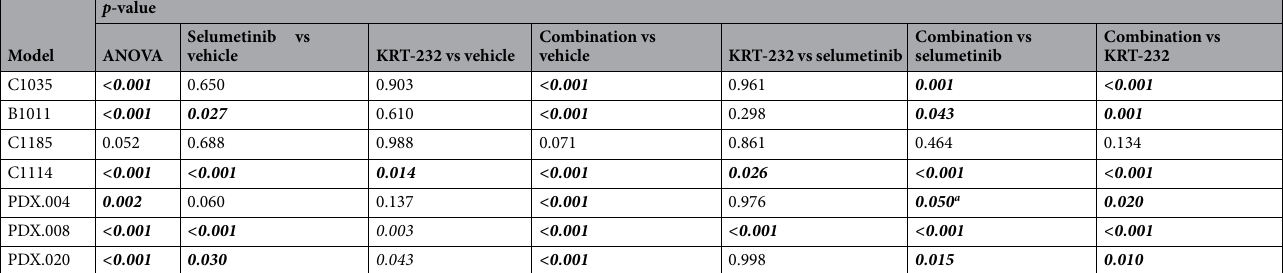
Table 2. Comparison of PDX tumor growth rates between groups. p -values < 0.05 were regarded as significant and are shown in bold italics. a The p -value was